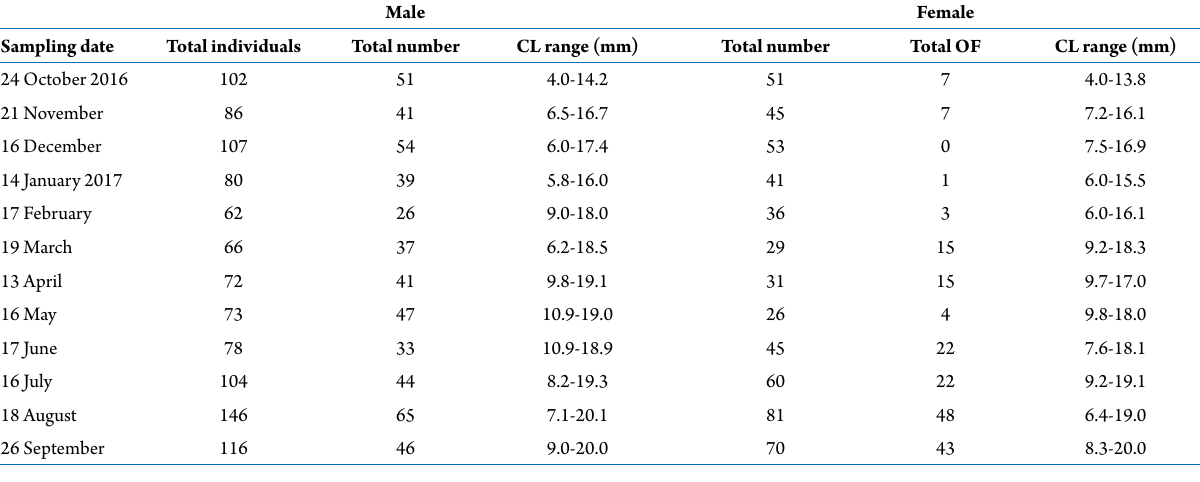
Table 1. Details of Macrobrachium lamarrei samples collected from a wetland, northeastern Bangladesh (CL = carapace length, OF = ovigerous females).